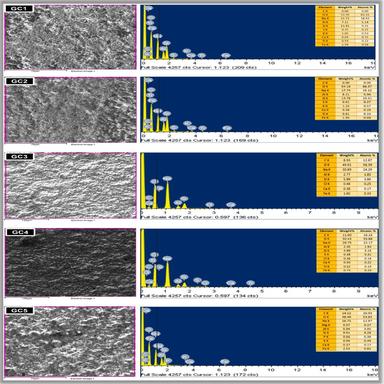
Microstructures and electronic elemental spectra of different advanced geopolymer mix compositions.